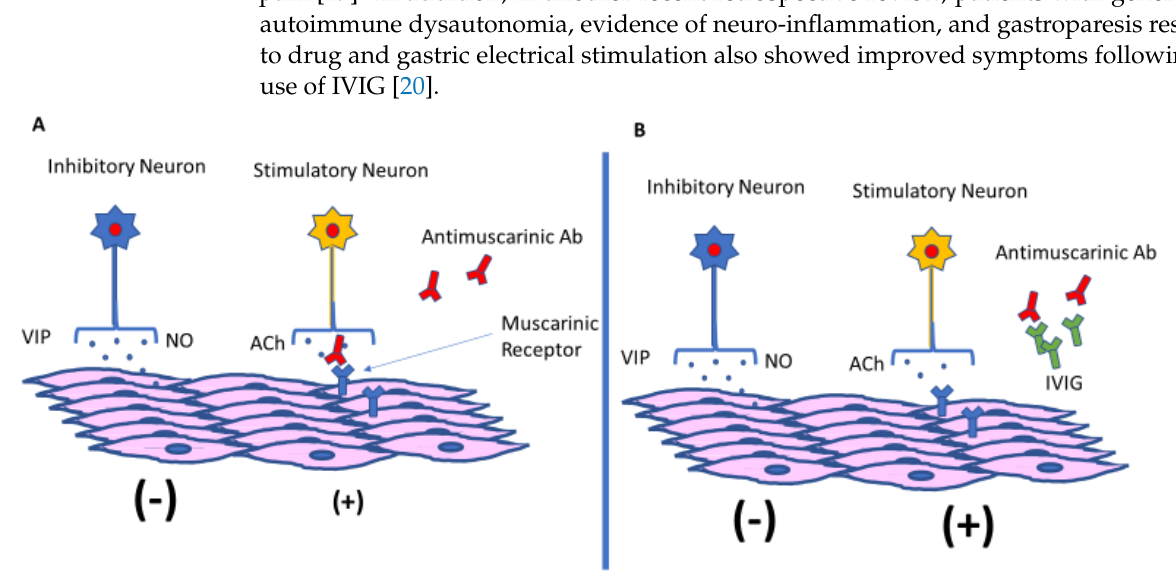
Figure 2. Hypothesized effect on IVIG in restoring GI motility in SSc patients. Motor neurons, stablish the connection of the enteric nervous system with the muscles of the GI tract. Excitatory and inhibitory neural signal allow proper GI motility. In SSc dysmotility, antibodies against ACh-muscarine receptors block stimulatory pathways, causing a predominance of the inhibitory signaling over the GI musculature. This imbalance is expressed as dysmotility with lack of proper peristalsis ( A ). IVIG, blocks the abnormal auto-antibodies, helping to restore the altered equilibrium and to recover normal motility ( B ). ACh: acetylcholine, VIP: vasoactive intestinal peptide; NO: nitric oxide.